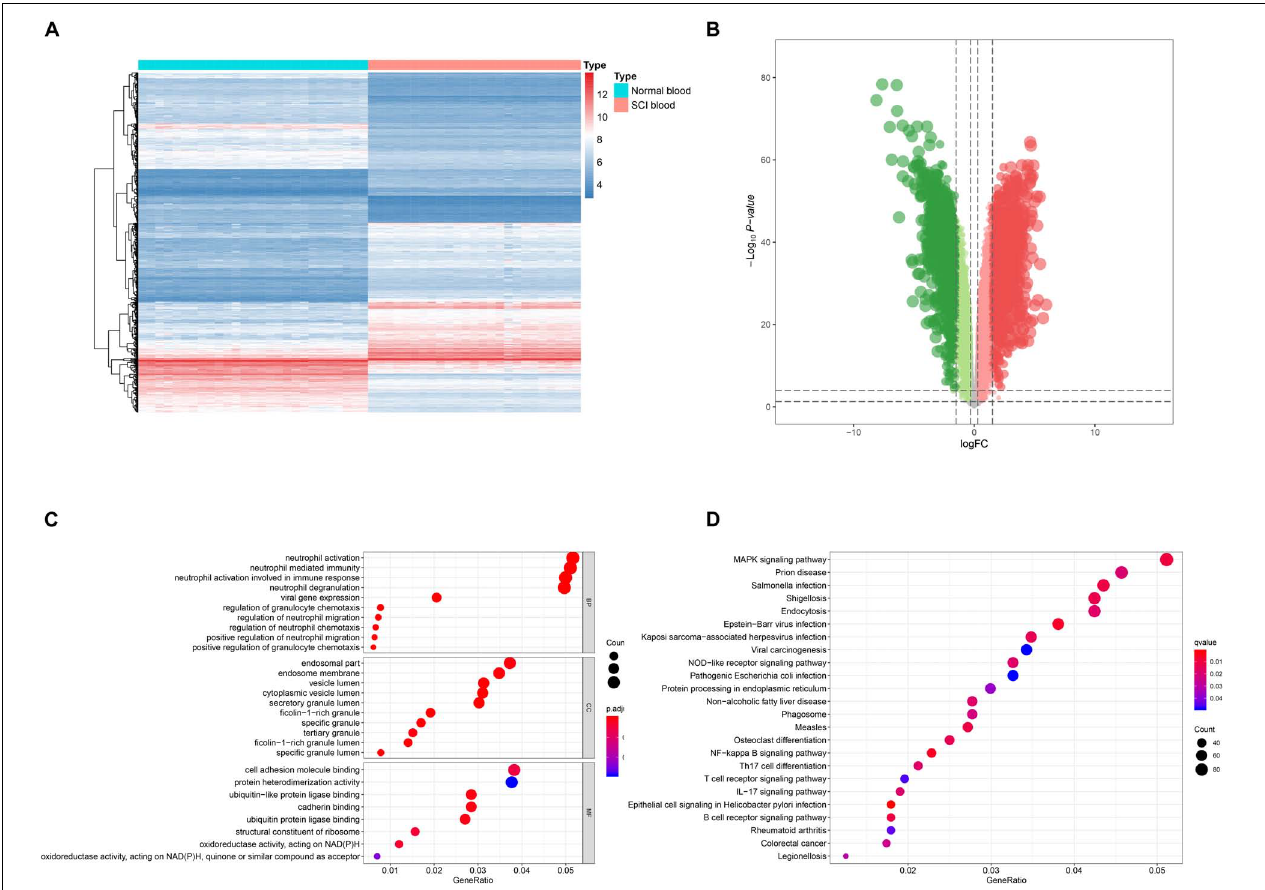
FIGURE 2 | Identification of differentially expressed enhancer RNAs (DEeRNAs) and functional annotation. (A) Heat map showing the expression level of DEeRNAs. (B) Volcano plot showing the p -value and log| FC| value of DEeRNAs by the differential expression analysis above. (C) The output of Gene Ontology (GO) analysis. (D) The output of Kyoto Encyclopedia of Genes and Genomes (KEGG) pathways enrichment